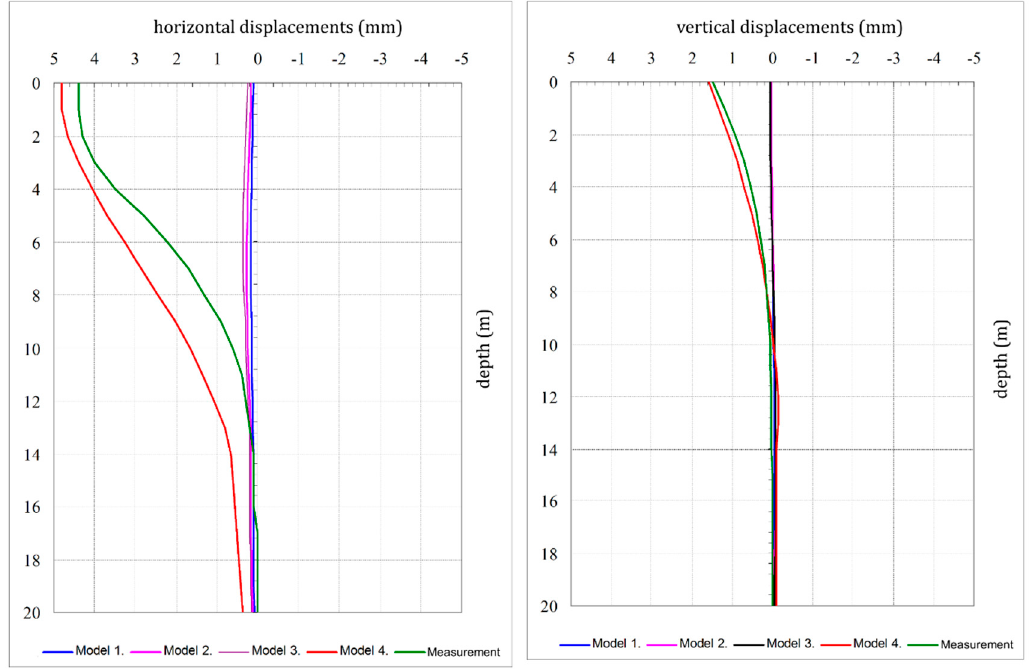
Figure 12. Comparison of measured and calculated horizontal and vertical displacements by using different stiffness models.